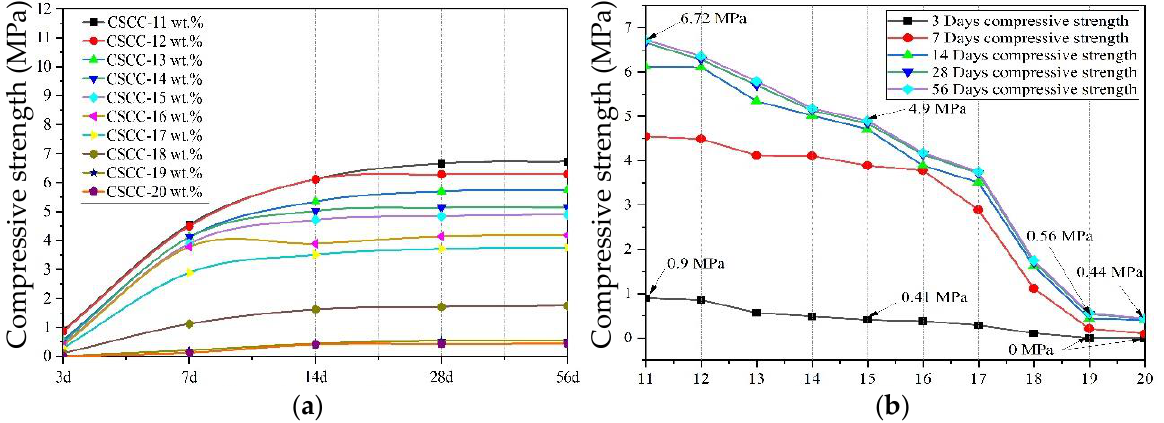
Figure 8. Relationship between compressive strength and age of samples. ( a ) Age of CSCC (d-days); ( b ) corn straw ratio (wt.%).